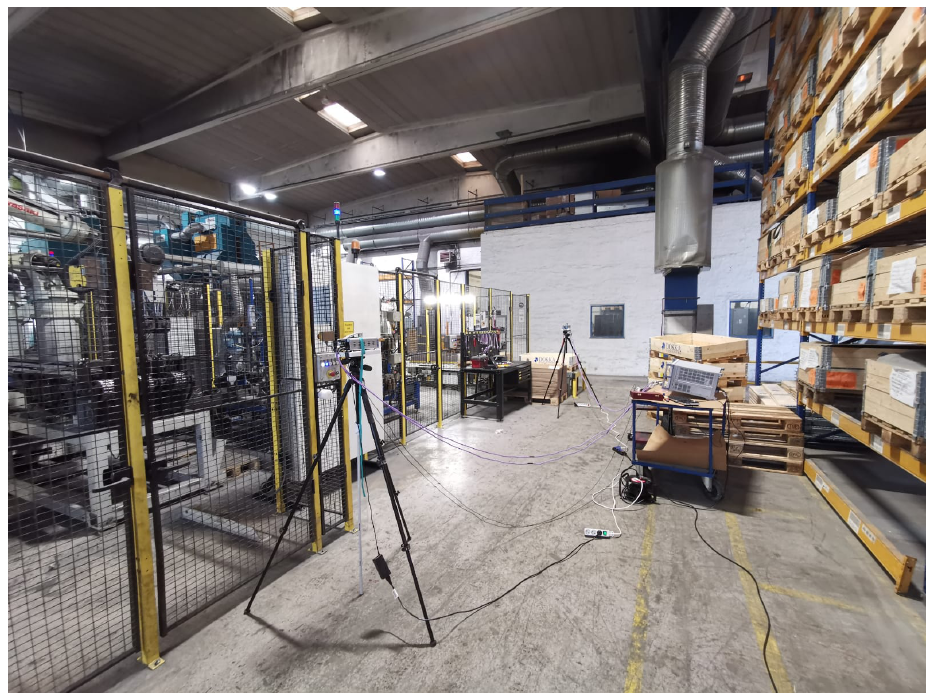
Figure 2. Measurement setup in Manufacturing hall at Dokka Fasteners AS. On the right side, the metallic shelves contain many pieces of heavy-duty equipment inside the wooden boxes. The left side contains many robotic types of machinery surrounded by a metal fence with an metallic alarm box and a grille door.